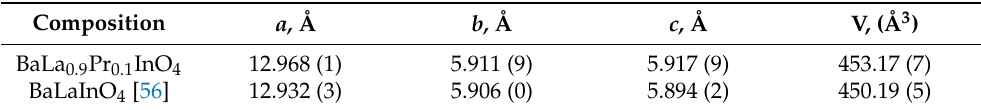
Figure 1. The results of the XRD—( a ) (R p = 2.11, R wp = 2.25, χ 2 = 1.32) and SEM-investigations ( b , c ) for the composition BaLa 0.9 Pr 0.1 InO 4 . Table 1. The geometric characteristics of the crystal lattice for the compositions BaLa 0.9 Pr 0.1 InO 4 and BaLaInO 4 .